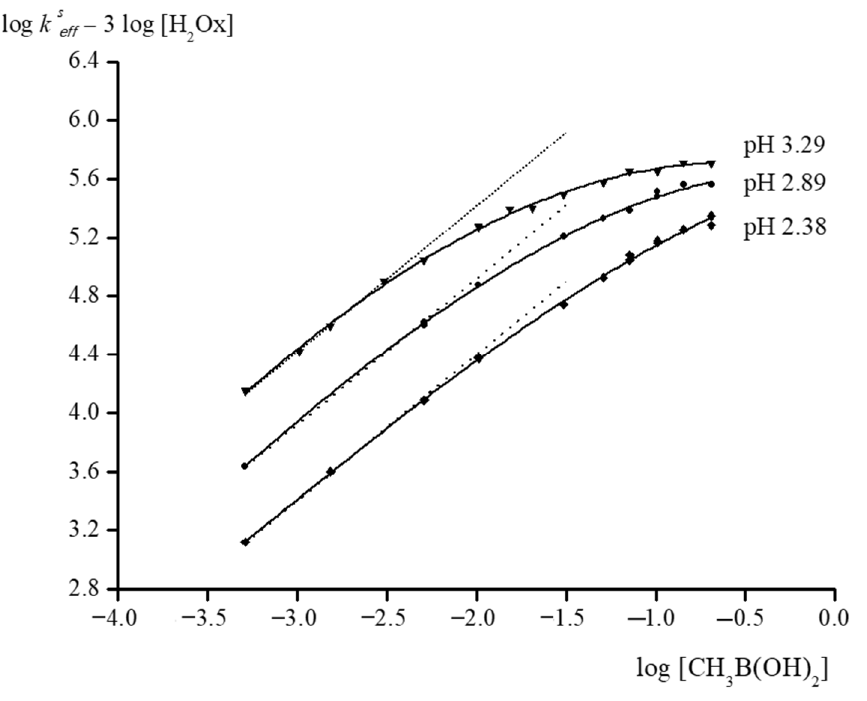
pa k ( ) − 3 log[H 2 Ox] versus Figure 6. Plot of log s Figure 6. Plot of log k s ( pa H + ) − 3 log[H 2 Ox] versus pa H + for the complex FeOx 3 (BCH 3 ) 2 ( 5 ) at + eff ef f H k ( pa Figure 6. Plot of log s ) − 3 log[H 2 Ox] versus [Fe 2+ ] = 2.5 × 10 − 5 mol L − 1 and [CH 3 B(OH) 2 ] = 1 × 10 − 2 mol L − 1 . [Fe 2+ ] = 2.5 × 10 − 5 mol L − 1 and [CH 3 B(OH) 2 ] = 1 × 10 − 2 mol L − 1 . + eff H [Fe 2+ ] = 2.5 × 10 –5 mol L –1 and [CH 3 B(OH) 2 ] = 1 × 10 –2 mol L –1 .